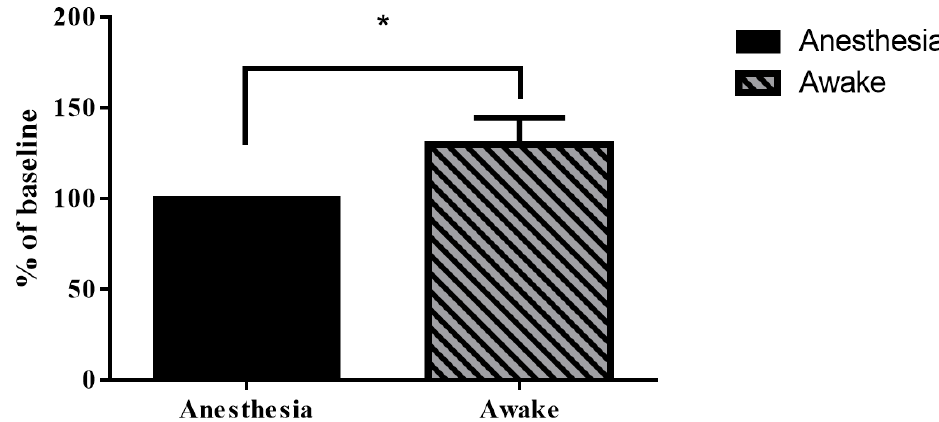
Figure 9. The percent of baseline blood vessel diameter from the PA B-scan image in anesthetized (black) and awake (gray) rats, with the anesthetized state as the baseline. There was a significant difference in the diameter of the blood vessels in the awake state compared to that in the anesthesia state. This result is in agreement with the result observed in the PA A-line. The reason may be that the brain is more active because awake rats exhibit continuous activity; thus, more nutrients must be transported by blood in the cerebral blood vessels, resulting in obviously increased blood vessel volume. Error bars represent SD. * p < 0.05 (Paired t -test, n = 3).